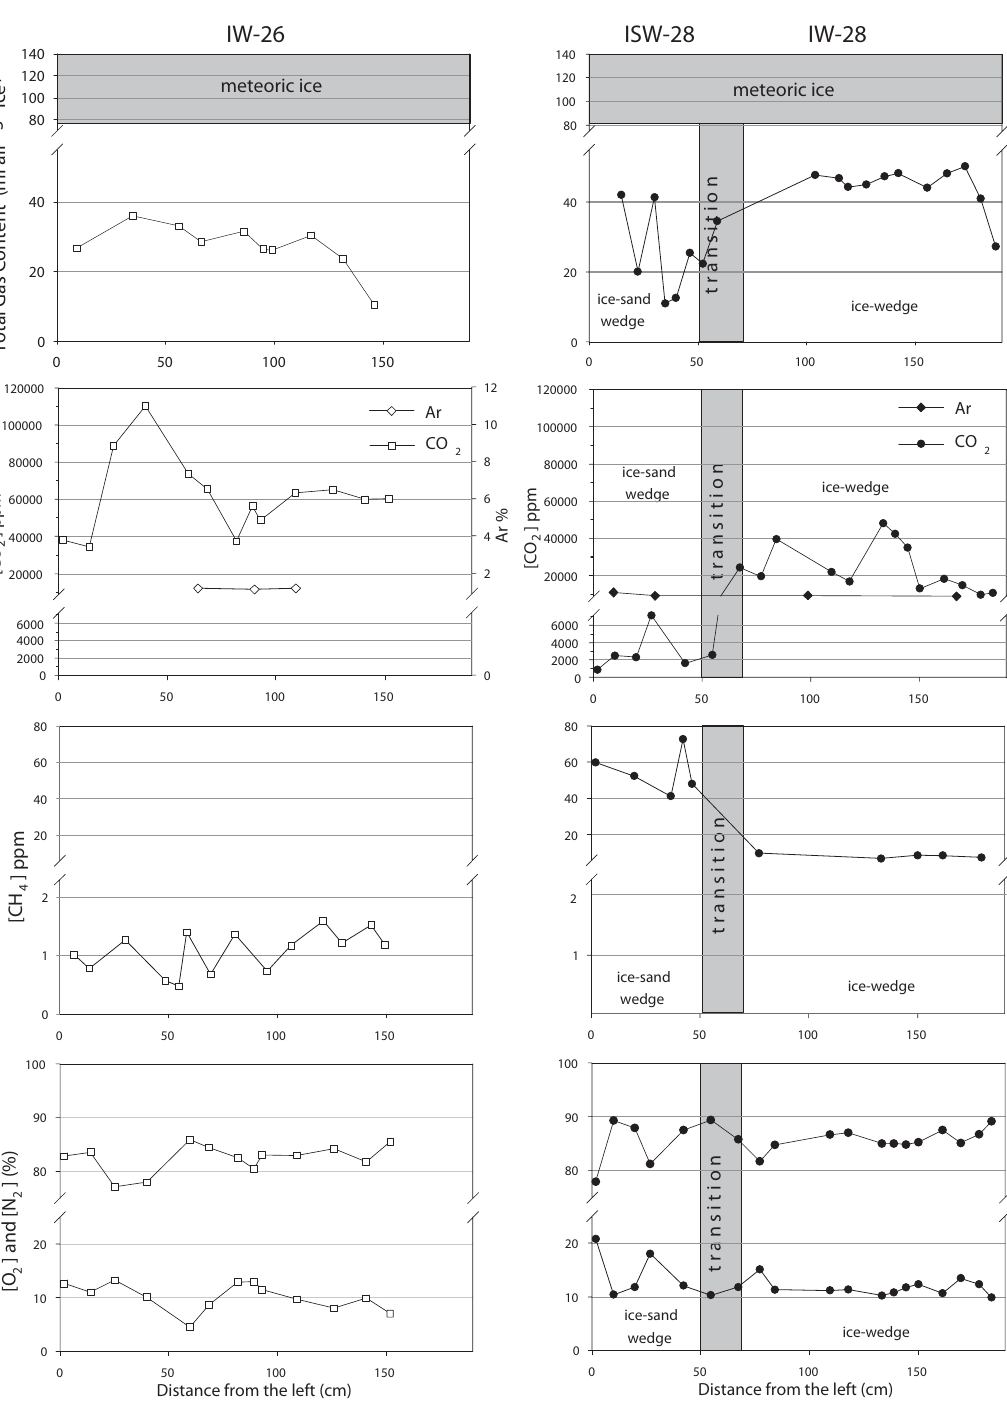
δ i = isotopic composition of the initial